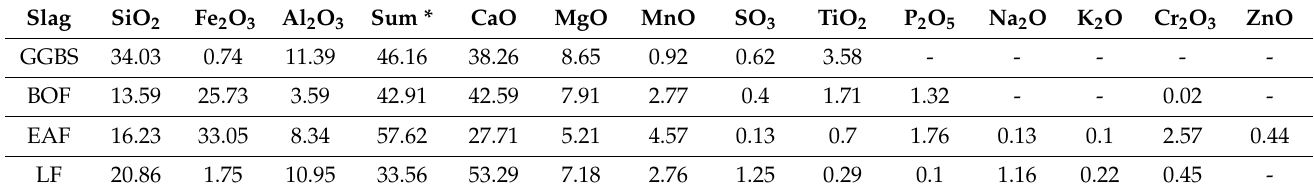
Table 11. Chemical composition of different metal slags (Note: Sum * is the sum of pozzolanic oxides) (adopted from ref.